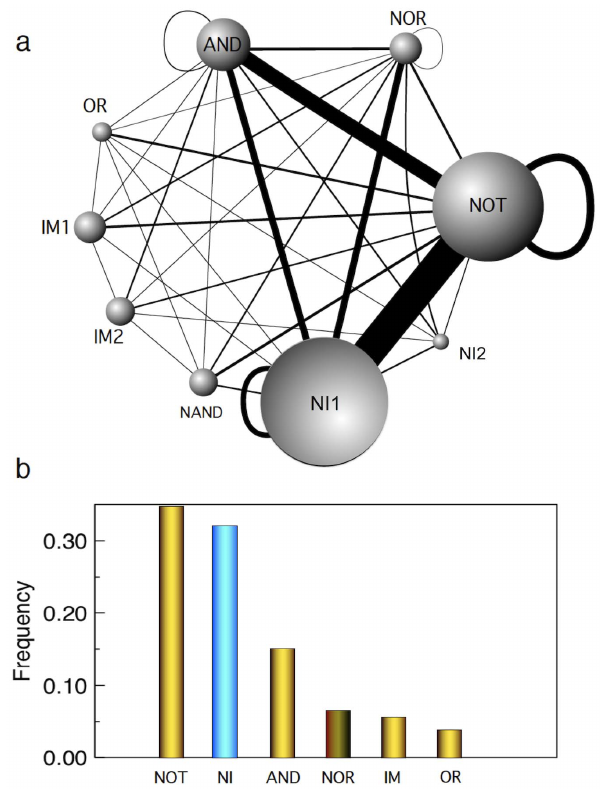
Figure 7. Graphs showing the frequency of gates in a MUX circuit. (a) Weighted graph showing the frequency of gates used in the generation of evolved MUX circuits under DMC. The diameter of the nodes is proportional to the frequency of the gate. Links indicate that two gates have been wired together within a circuit. The weights provide a measure of how frequently a given pair has been used. Note the disproportionate frequency of N-implies ( NI 1 ) which are typically connected to NOT and AND gates, much less with NOR gates. Note also the vanishing frequency of NOR-NOR links (see text). In (b) we summarize the relative frequencies of different gates. The two N- Implies gates (here NI=N1 + IN2) have been added together. These and the NOR abundances are highlighted with distinctive colours. Circuits were evolved imposing minimal number of wires.